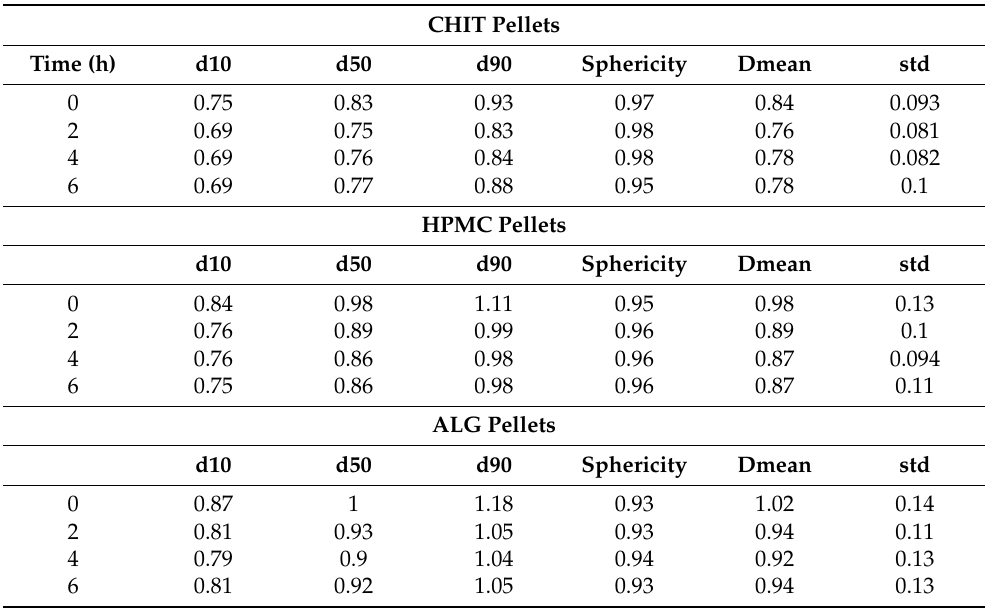
Table 2. Pellet size alteration and sphericity alteration during dissolution